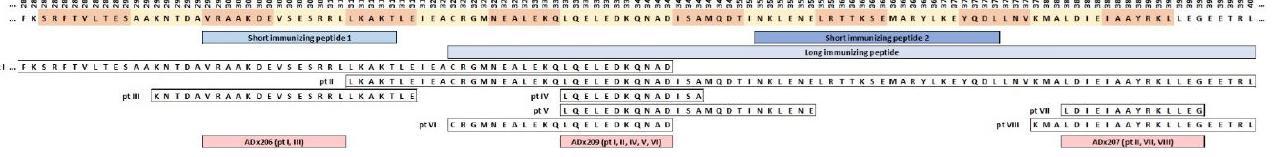
Figure 2. Epitope recognition sites of ADx206, ADx209, and ADx207 antibodies in the Coil 2/B region of Nf-L protein. The two short and one long peptide immunization sites (Section 4.1) are defined in the figure. Eight synthetic peptide sequences (pt I to pt VIII) defined in the figure were used to map the epitopes recognized by the antibodies.